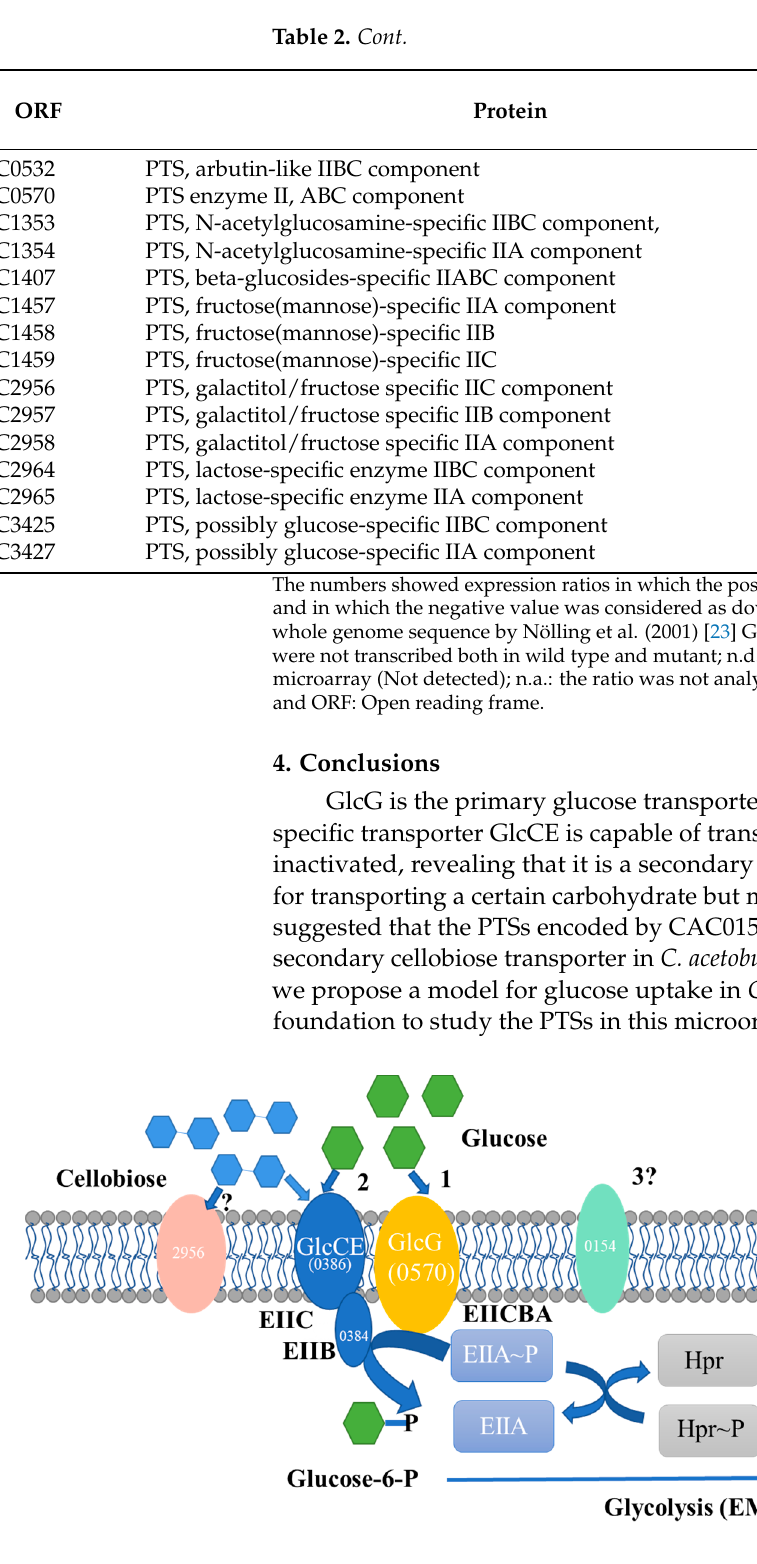
Figure 6. Glucose uptake model for C. acetobutylicum. 1, 2 and 3: work order of the glucose trans ‐